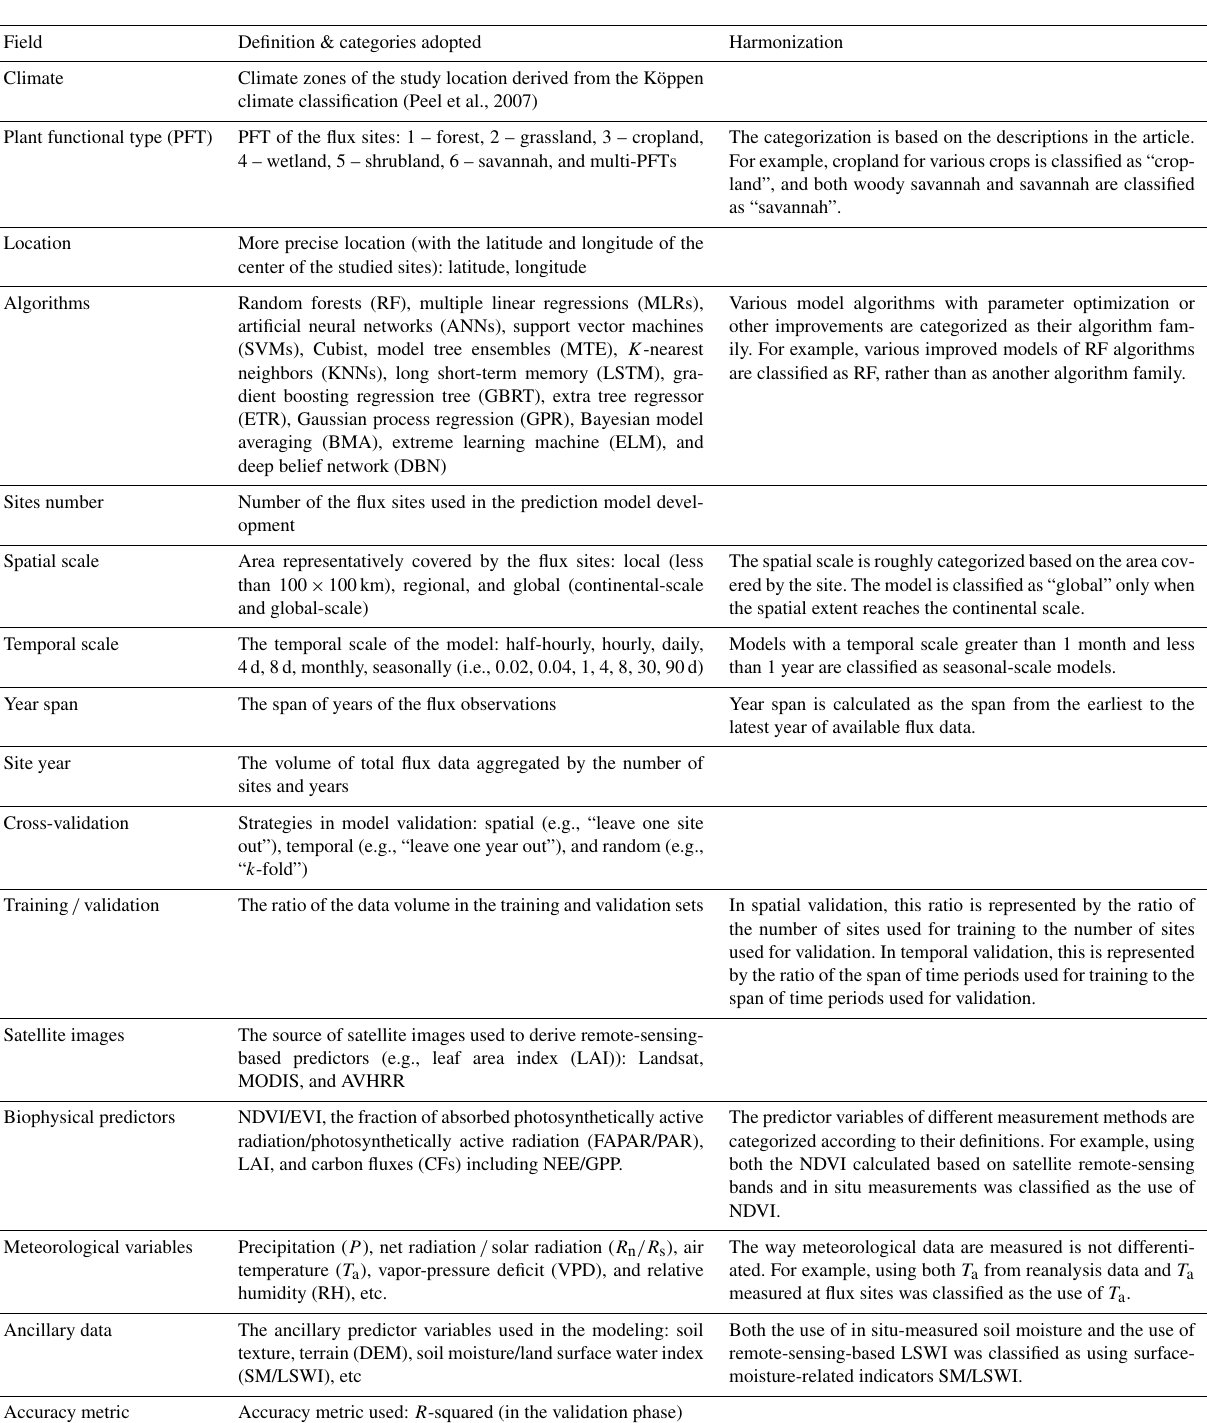
Table 2. Model feature-related information collected from the papers included in this